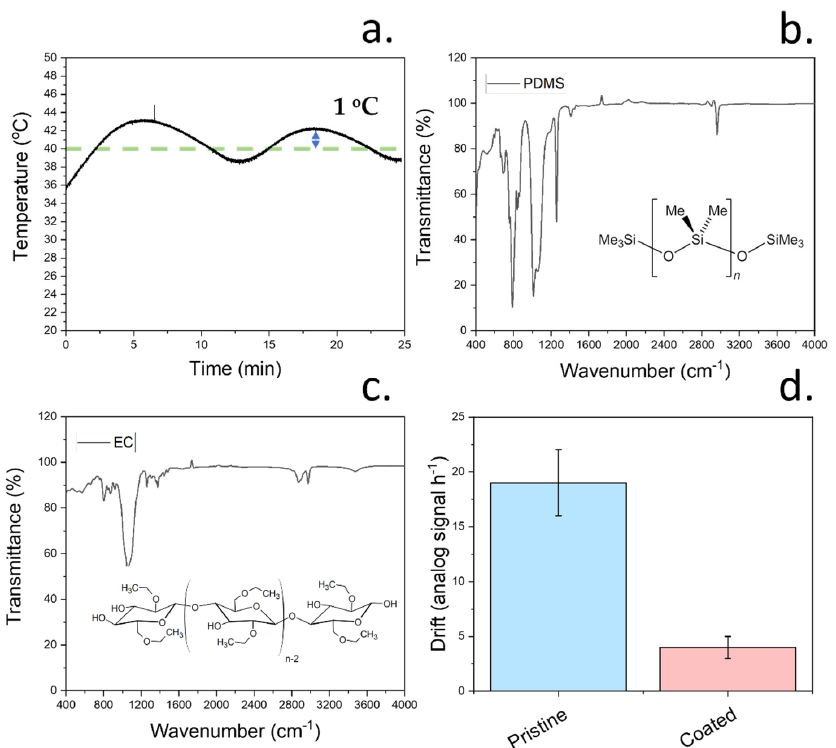
Figure 5. ( a ) Monitoring of substrate temperature using a TM32 sensor with an Arduino device and incorporating a heating element to maintain the surface at a stable temperature. In this case, the substrate temperature was set to 40 °C, and the changes in temperature due to the feedback loop using the temperature sensor can be observed. ( b ) FTIR spectrum of pure PDMS after deposition onto a glass substrate at 40 ° C. All the stretches corresponding to PDMS molecules are present. The molecular structure of PDMS is indicated. ( c ) FTIR spectrum of ethyl cellulose after deposition onto a glass substrate at 40 °C. The molecular structure of ethyl cellulose is also indicated. ( d ) Measured drift from pristine and coated pH sensors. The error bars indicate the standard deviation from trip ‐ licate measurements.